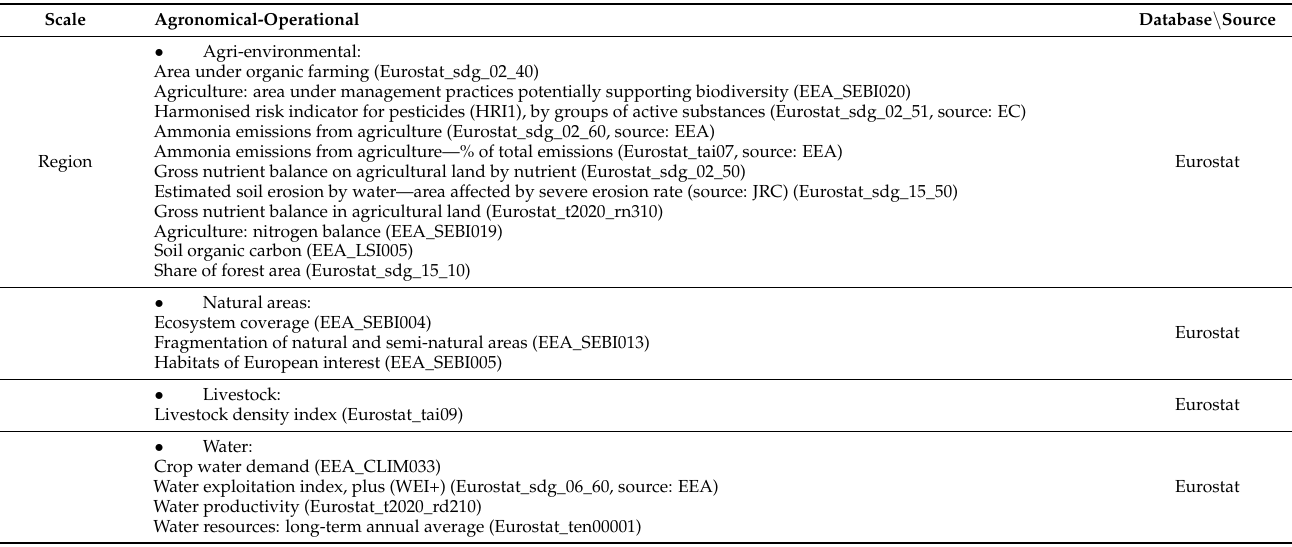
Table A1. Integrated indicators’ list divided by scale and